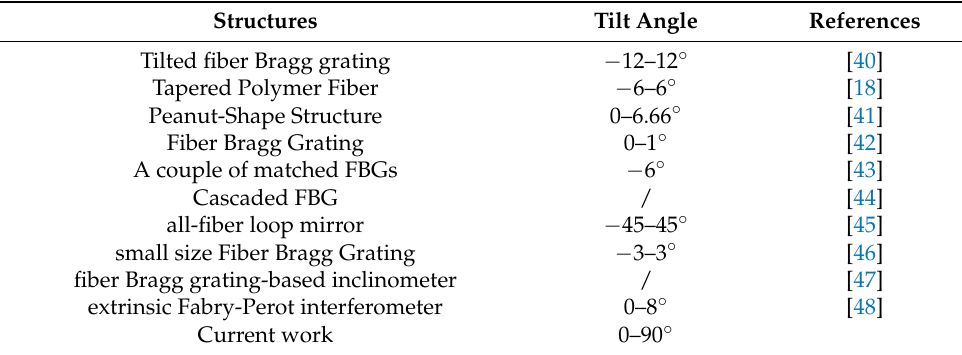
Table 1. The detection range comparation with other optical fiber inclinometer.